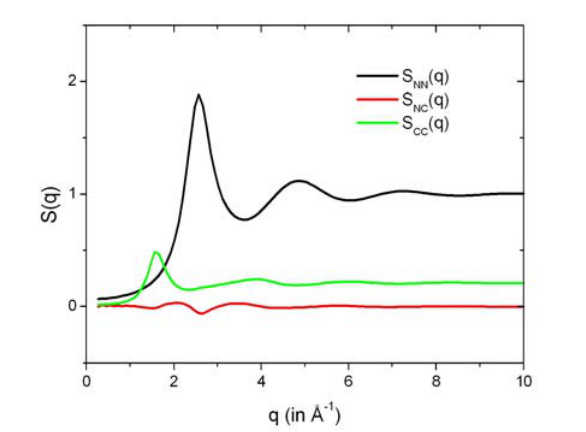
Fig. 4. Bhatia Thornton partial structure factors obtained from classical